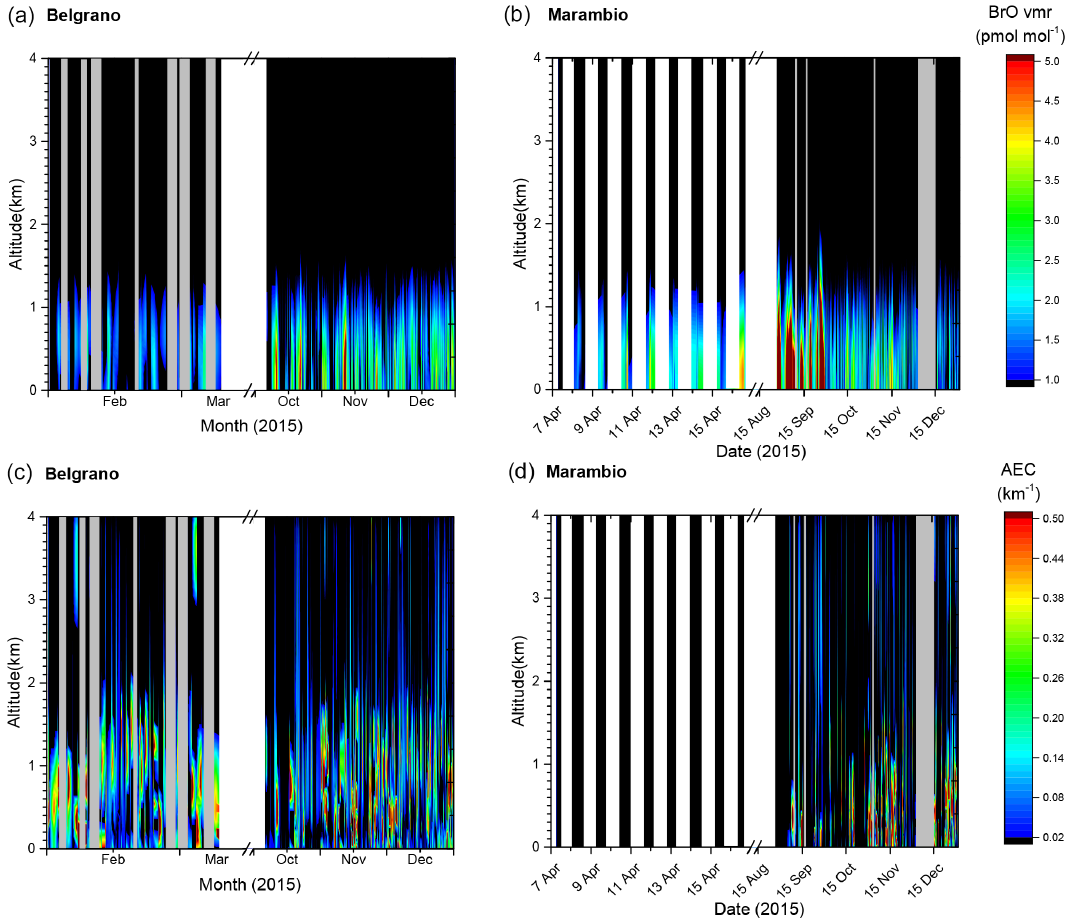
Figure 7. BrO vmr (a, b) and AEC (c, d) observed during 2015 in the troposphere of Belgrano (a, c) and Marambio (b, d) . The vertical scales show the altitude and are forced to be the same for the sake of comparison. The horizontal scales indicate the periods of the measurements, which depended on the station. The color code of the upper figures corresponds to the BrO vmr and is forced to be the same for the sake of comparison. The same applies to the color code of the lower figures, which indicate the AEC at each station. The BrO vmr higher than 5pmolmol − 1 and AEC higher than 0.5km − 1 are shown in dark red, while values below the detection limit are shown in black. Time periods with no observations (SZA>75 ◦ ) are indicated with white areas and those with data below quality filters are shown with grey areas. The vertical grid of the retrieval is indicated with the small ticks in the vertical